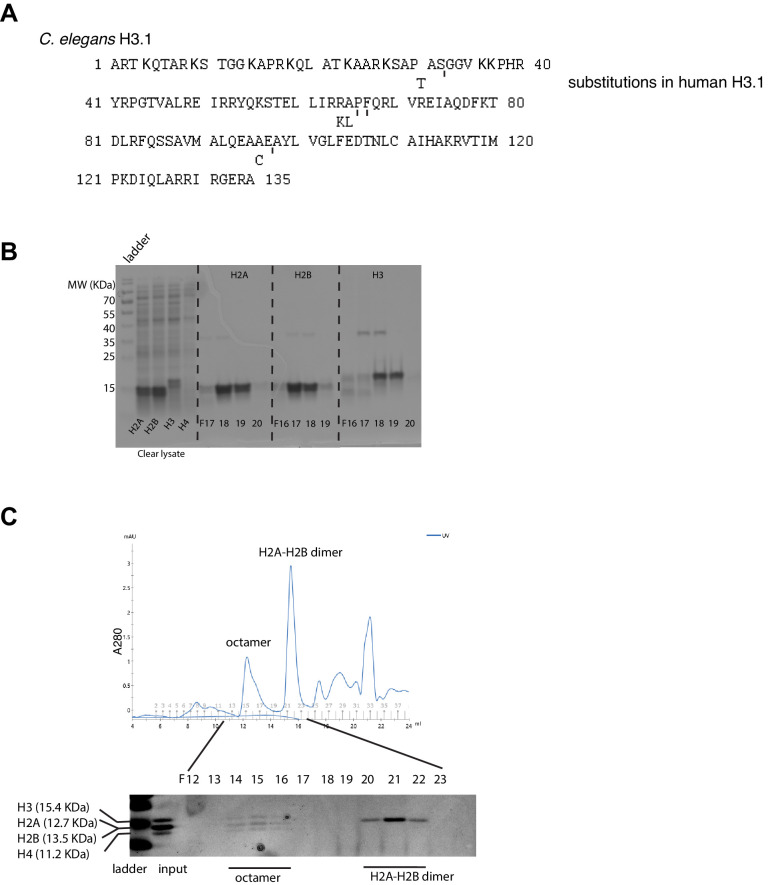
Recombinant histone purification and histone octamer assembly.(A). C. elegans H3.1 protein sequence, lysine residues within the first 40 residues in bold. The differences with human H3.1 sequence are indicated. (B) SDS-PAGE/coomassie analysis of C. elegans histone expression and purification. Lysate before HiTrap SF fractionation are shown to indicate expression of H2A, H2B, and H3, but not H4 in E. coli. Peak fractions of HiTrap SF chromatography are shown for H2A, H2B, and H3. (C) Size exclusion fractionation of histone octamer assembly. C. elegans H2A, H2B, H3 and Xenopus H4 were used. Xenopus H4 (Histone Source) is identical to C. elegans H4 except at position 74 (threonine in Xenopus and cysteine for C. elegans). (C. elegans and Xenopus H2Bs have the identical protein sequence. The percentages of identity between the two species are 81.7% and 95.6% for H2A and H3, respectively.).